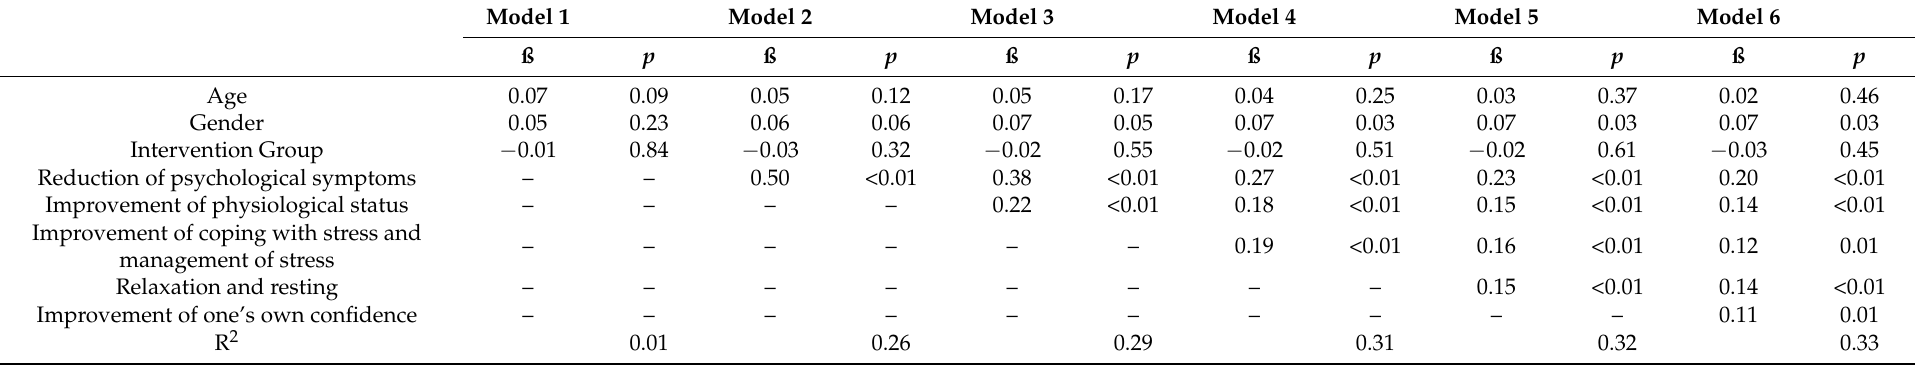
Table 2. Step-wise hierarchical regression results predicting satisfaction with rehabilitation post-rehabilitation by reaching rehabilitation goals in n = 663 rehabilitation